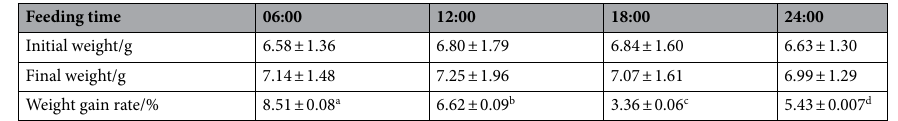
Table 1. The impact of feeding time on the growth performance of Chinese velvet crabs. Weight gain rates with different superscripts are significantly different between feeding times (Duncan Test, p <